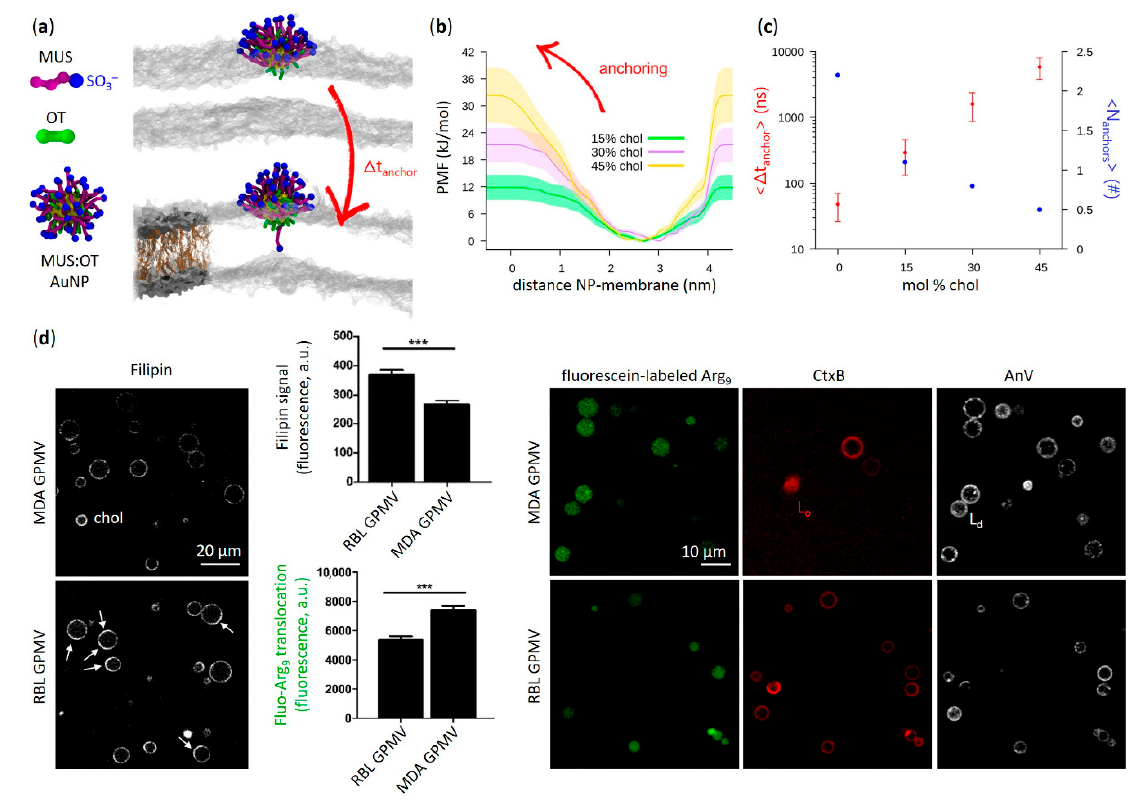
Figure 4. Translocation of amphiphilic AuNPs and amphiphilic peptides is favoured into lipid membranes with lower cholesterol content. ( a ) Left: coarse-grained structure of hydrophilic (MUS) and hydrophobic (OT) ligands and an amphiphilic MUS:OT AuNP in water (2 nm core size; water not shown). Right: simulation snapshots showing the ligand anchoring typical of these AuNPs (see Figure 1b). The NP goes from the hydrophobic contact state (top) to the anchored state (bottom) in which one MUS charged terminal is in contact with the lipid heads (transparent gray) of the distal leaflet. Cholesterol molecules—intercalated between the apolar tails of membrane phospholipids (DOPC)—are shown in tan in the membrane detail on the bottom left. ( b ) Anchoring free energy barriers calculated with well-tempered metadynamics simulations at different membrane cholesterol concentrations. ( c ) Average anchoring time ( Δ t anchor ) and average number of anchored ligands after 1 μ s (N anchors ) obtained from unbiased MD simulations as a function of membrane cholesterol content. ( d ) Translocation of the Arg-rich CPP nona-arginine (Arg 9 )—labeled with fluorescein (green)—into GPMVs derived from MDA-MB-231 (MDA GPMV) and RBL-2H3 (RBL GPMV) cells. Left images: GPMVs labeled with filipin (pseudo-colored as white) to bind membrane cholesterol and enable its visualization. Right images: GPMVs labeled with Alexa Fluor 555-conjugated cholera toxin B subunit (CtxB, red) and Alexa Fluor 647-conjugated annexin V (AnV, pseudocolored as white) to visualize, respectively, the L o membrane domains and phosphatidylserine contained in the outer leaflet of the limiting membrane of both vesicle types. Quantification of the filipin signal shows that MDA GPMVs contain approximately 30% less membrane cholesterol than RBL GPMVs; in addition, RBL GPMVs show several large cholesterol-enriched subdomains (white arrows) that are rarer in MDA GPMVs. Overall, Arg 9 translocation is significantly reduced in vesicles character- ized by higher membrane cholesterol content and more cholesterol-rich membrane microdomains. *** p -value < 0.0001 and 0.0005 for filipin signal and fluo-Arg 9 translocation, respectively. ( a – c ) contain images by Canepa et al. [45] reprinted with minor modifications—Copyright © 2022 The Authors, published by American Chemical Society. ( d ) is reproduced and adapted with permission from Lorents et al. [111]—Copyright © 2022 American Chemical Society.